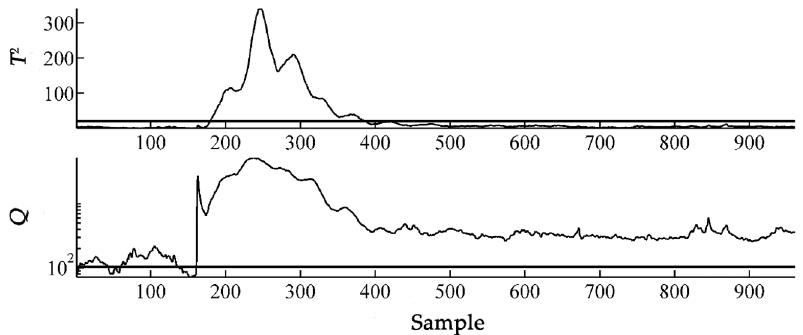
Figure 5. Monitoring results of the statistical pattern analysis (SPA) approach for fault